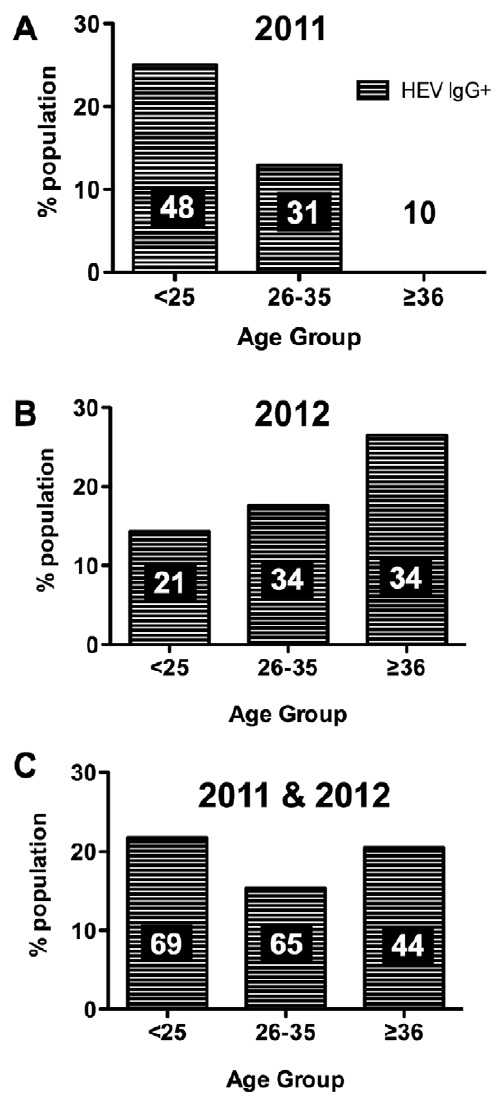
Figure 4. Distribution of anti-HEV IgG in blood donors according to age group. A) in January 2011; B) in March 2012; C) groups 2011 and 2012 combined.